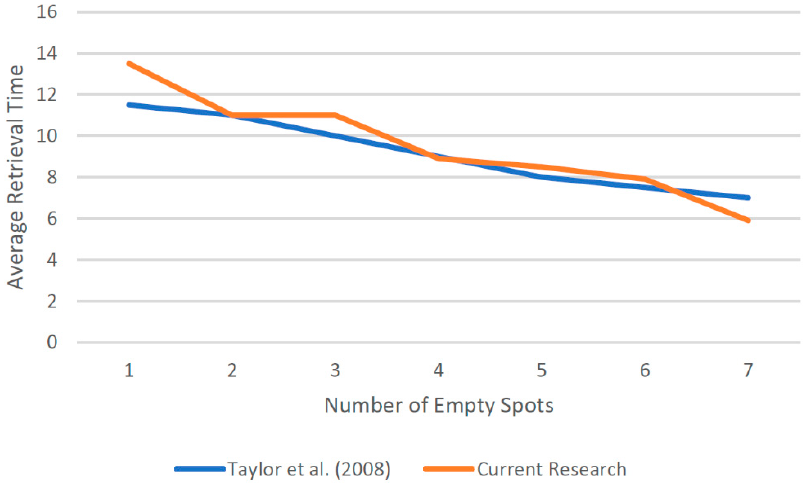
Figure 20. Comparison of our algorithm’s and Taylor and Gue’s (2008) results in the random dis ‐ tribution